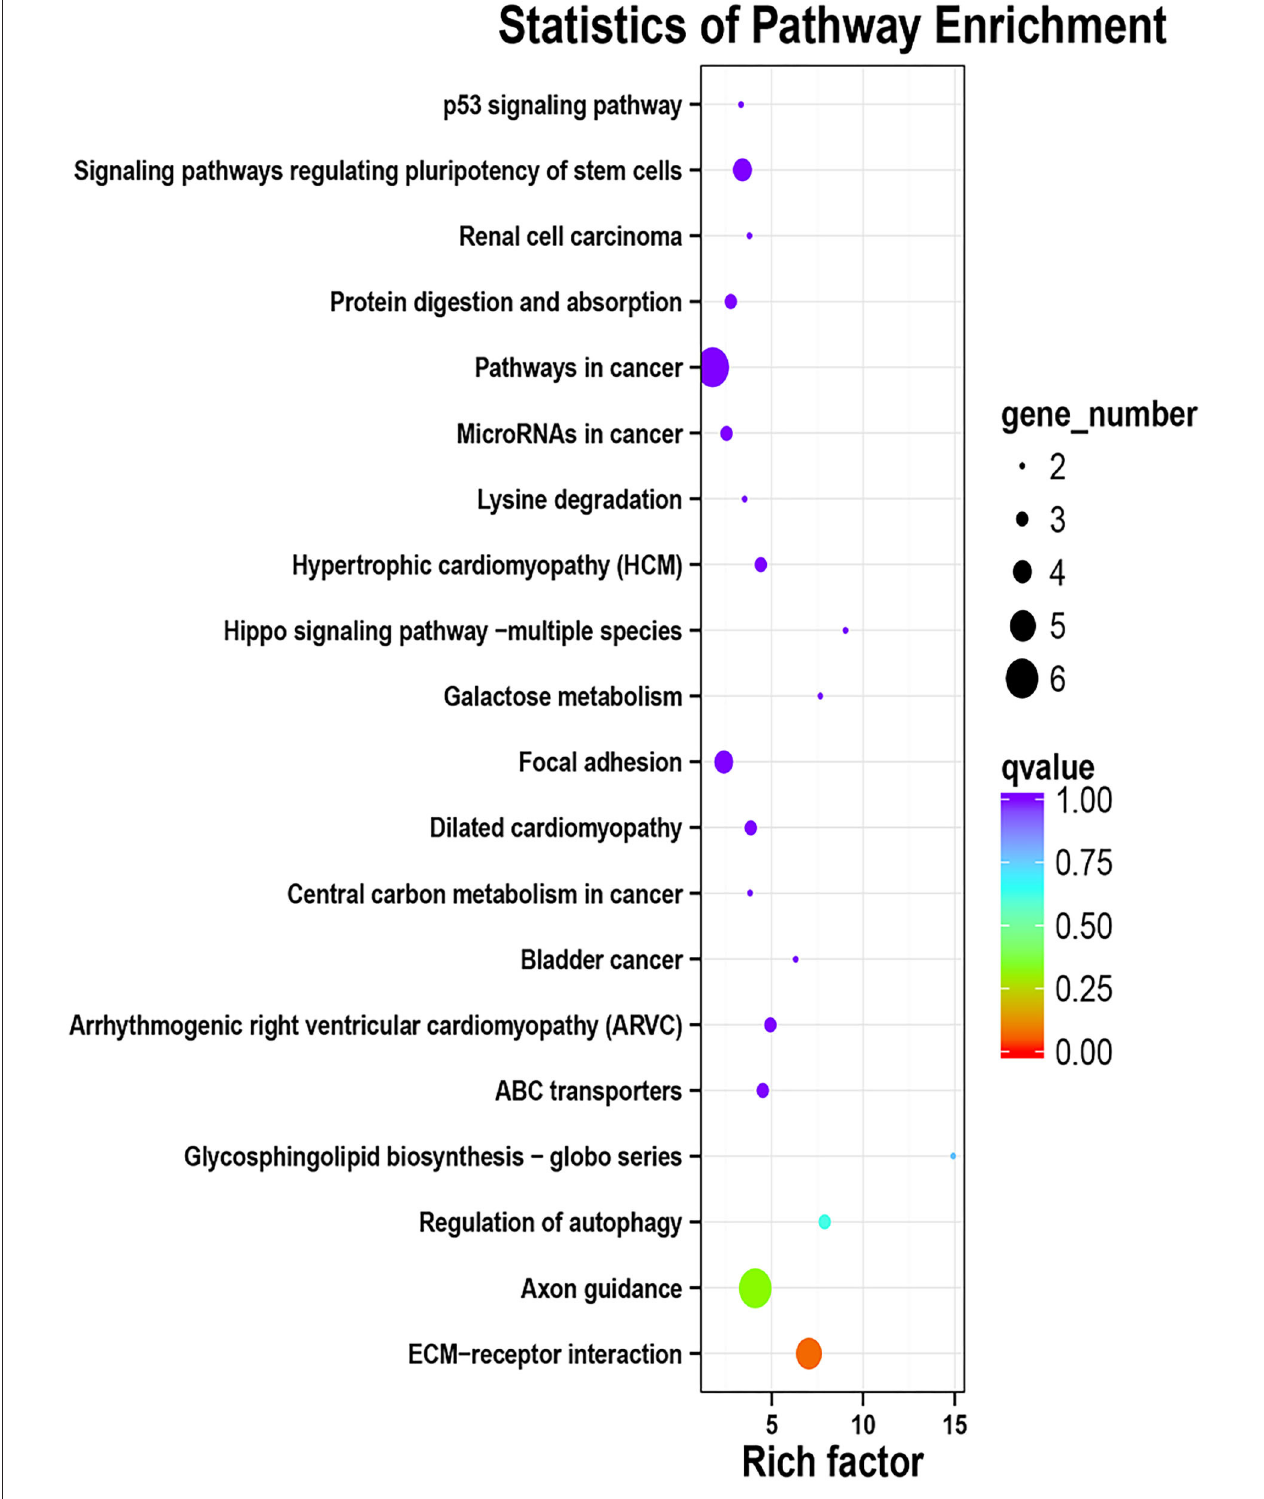
FIGURE 3 | KEGG enrichment analyses of the up-regulated DEGs in jejunum of neonatal goats suffering from diarrhea as compared with control goat kids. The vertical axis represents the pathway category, and the horizontal axis represents Enrichment Factor which means the proportion of DEGs annotated to the pathway on genes annotated to the